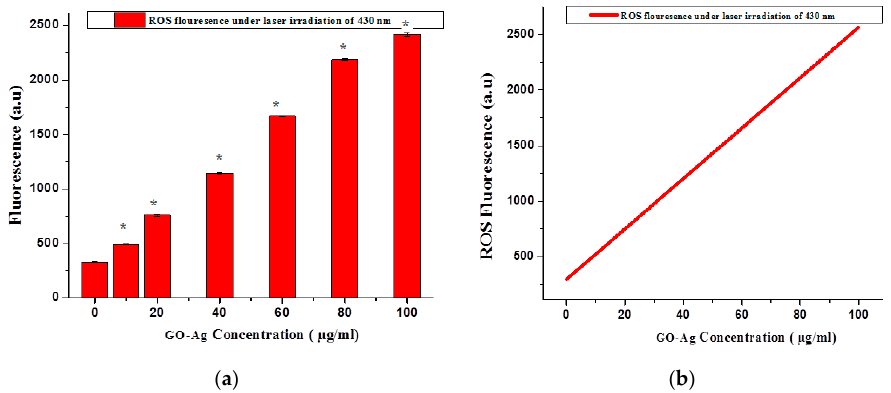
Figure 12. ( a ) ROS generation under light irradiation of suitable wavelength (430 nm), t -test ( * p < 0.05); ( b ) Linear calibration Plot of GO-Ag concentrationvs. ROS fluorescence under PDT (100 J/cm 2 ).